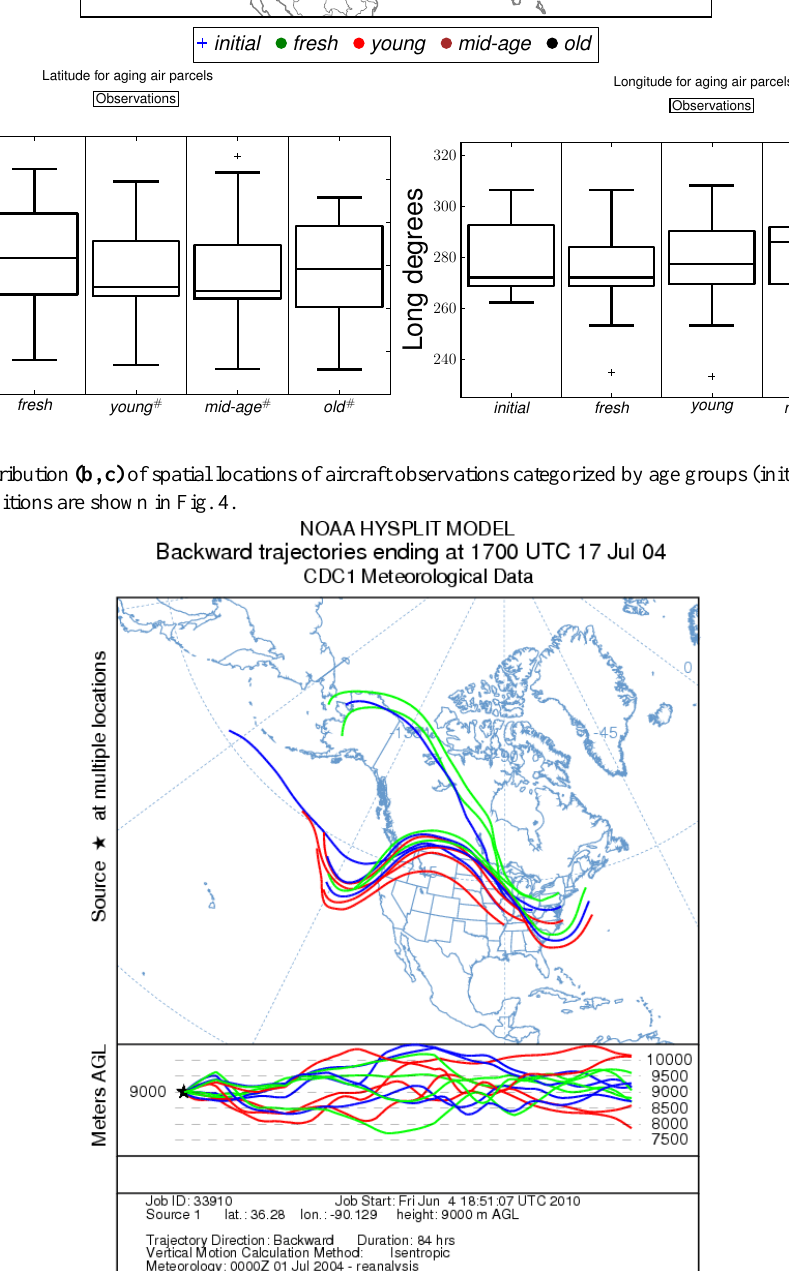
Fig. A2. HYSPLIT back trajectories for 12 northeast locations at 9km altitude with only more than half of the air parcels originating between 8 and